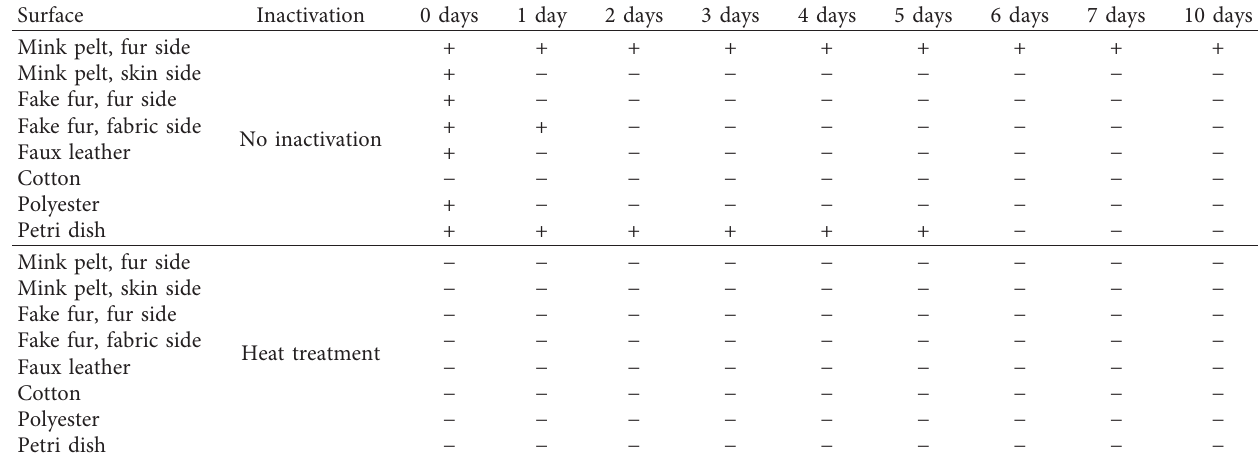
Table 2: Stability of SARS-CoV-2 on surfaces without inactivating treatment and after heat treatment at 60 ° C for 1h.